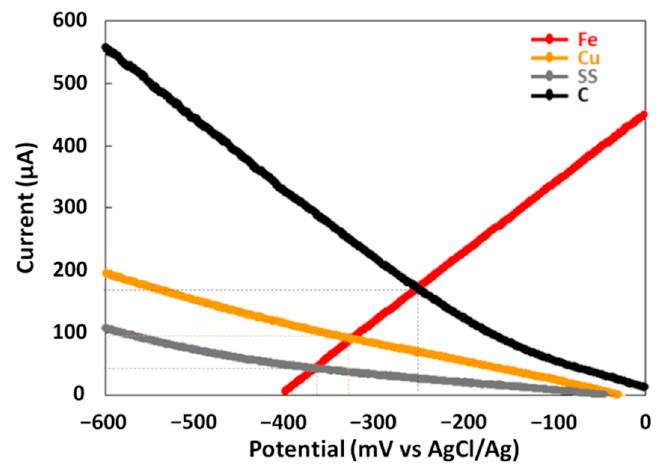
Figure 3. Corrosion potential and current corrosion of iron electrode coupled to different cathodes.